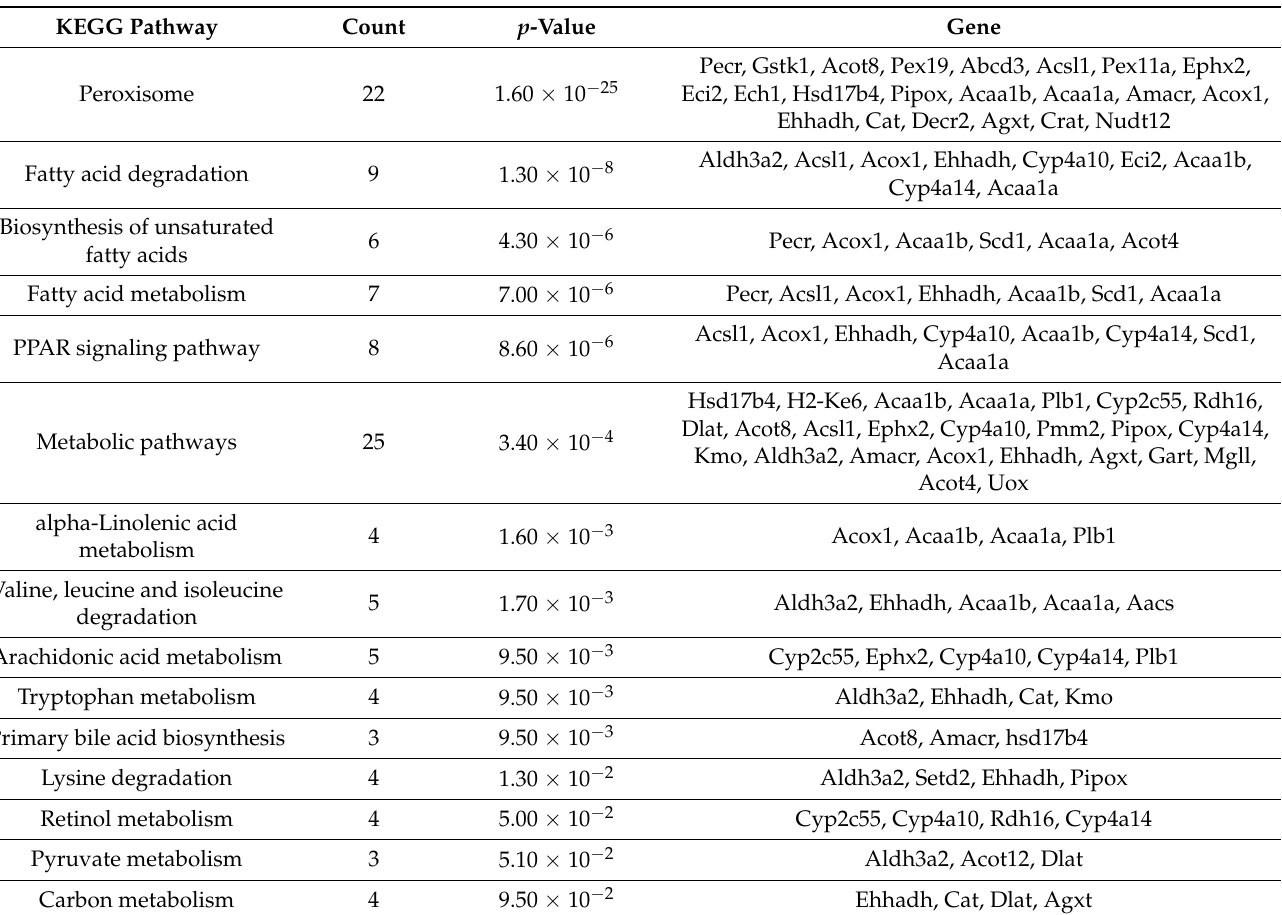
Table 1. KEGG pathway analysis of upregulated proteins in Hacl1 − / − mouse